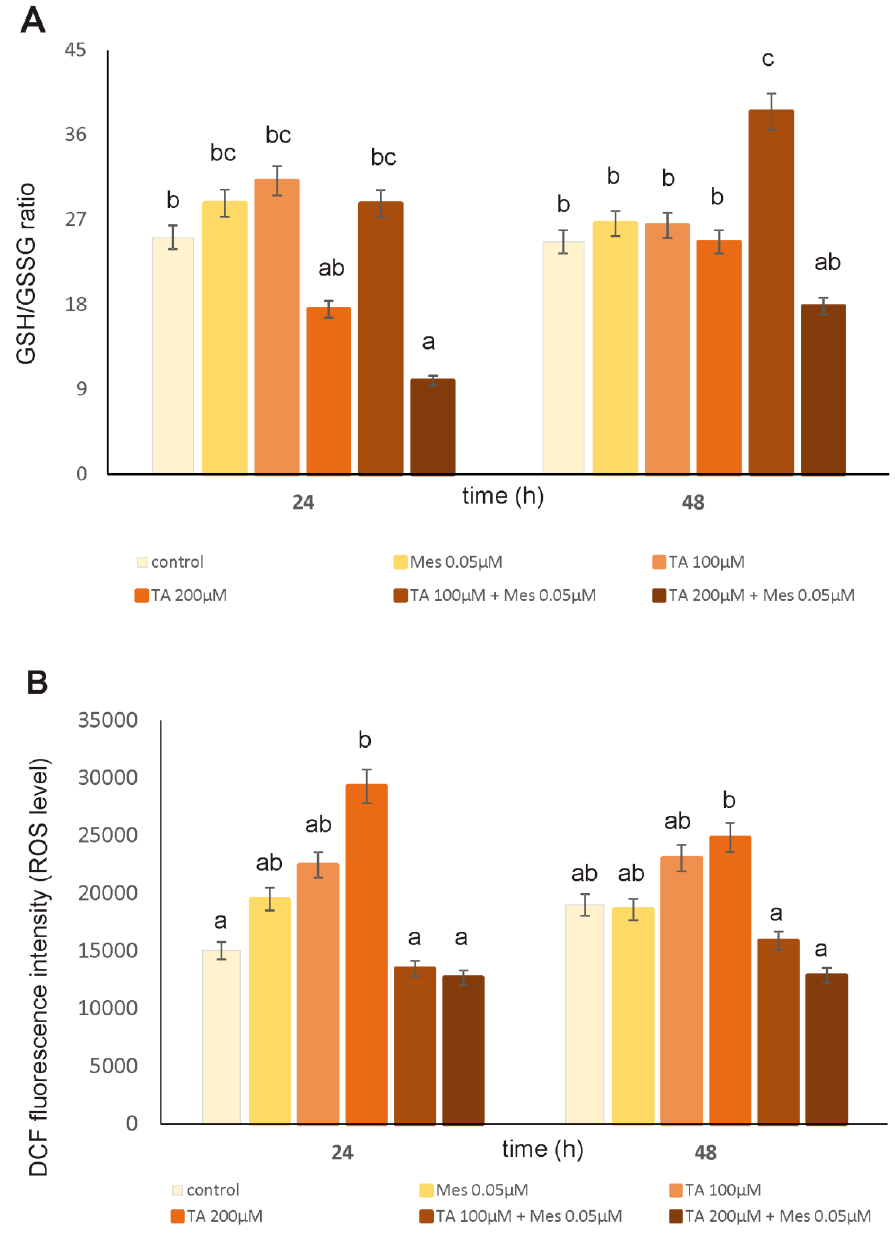
Figure 5. The influence of TA, Mes and the mix of TA and Mes on GSH / GSS (GSH–reduced form of glutathione, GSSG–oxidized form of glutathione) ratio ( A ) and reactive oxygen species (ROS) content ( B ) in ZR-75-1 cells. The cells were cultured with 100 µ M TA, 200 µ M TA, 0.05 µ M Mes, and a mix of 100 µ TA + 0.05 µ M Mes, 200 µ M TA + 0.05 µ M Mes for 24 h and 48 h. Mean values from three independent experiments ± SD are shown. Di ff erent letters indicate statistical di ff erences ( p ≤ 0.05) between each treatment estimated by Tukey’s test.